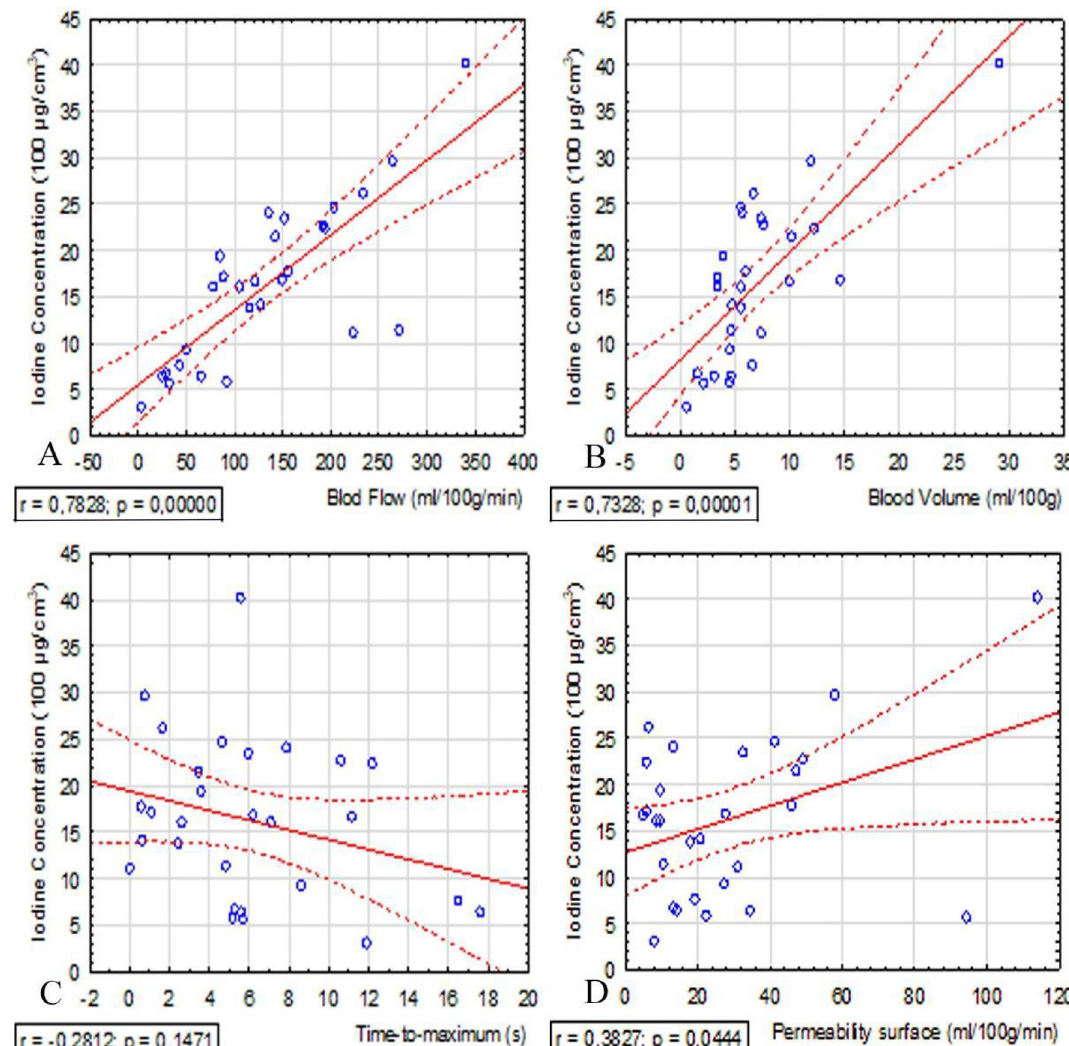
Figure 5. Scatterplot displaying Pearson correlation between the Blood Flow ( A ), the Blood Volume ( B ), the Time to maximum of the residue function ( C ), the Permability surface ( D ) at CTP and iodine concentration at DECT in SPNs with upper and lower lines indicating 95% confidence intervals. SPNs, SPN solitary pulmonary nodule, r correlation coefficient, p statistical